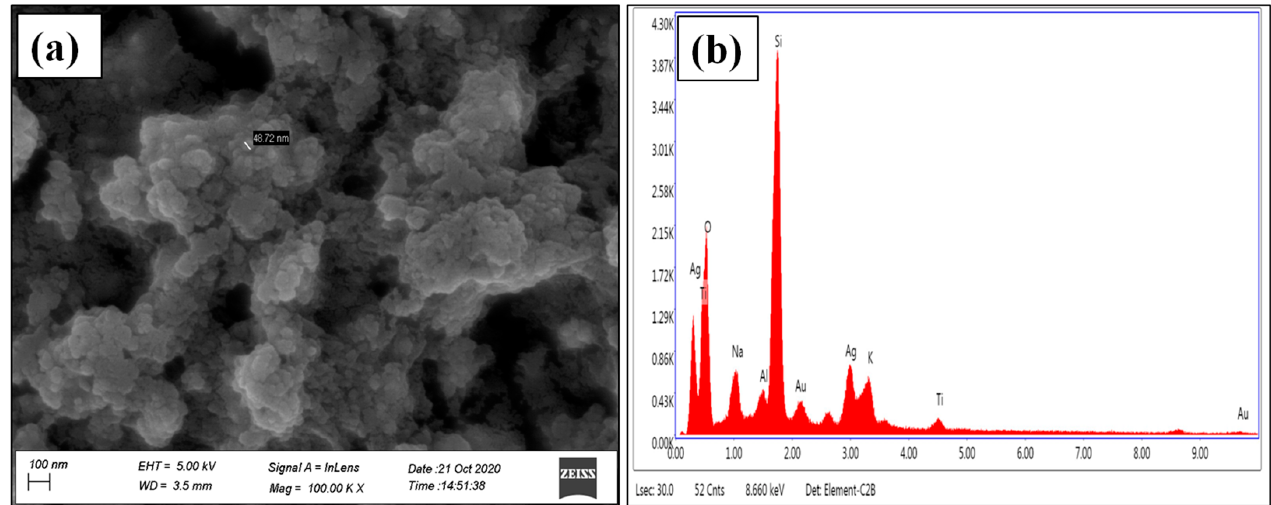
Figure 4. ( a ) FESEM recorded at the scale of 100 nm and ( b ) EDX image of synthesized AgNPs.